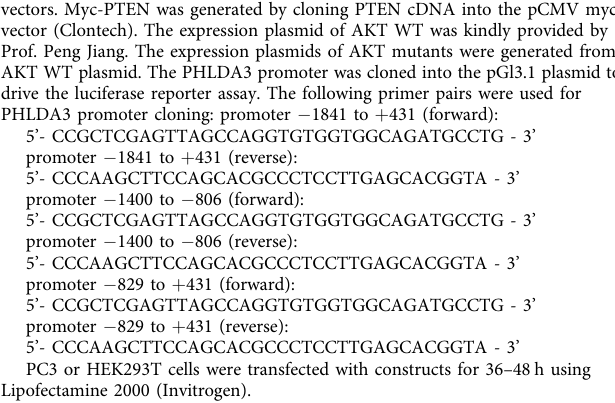
Fig. 7 PPP controls cell proliferation and survival in vivo. a – c The effects of PPP inhibition in the Pten null prostate cancer and T-ALL mouse models. Mice were treated with of 6-AN (15 mg/kg) for 24 h. Metabolites were measured by LC-MS (left panel). mRNA and proteins were detected by RT-PCR